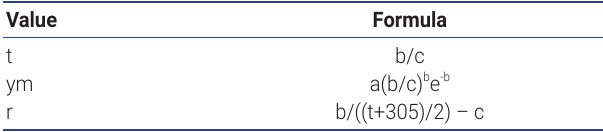
Table 2. Calculation of some characteristics of lactation